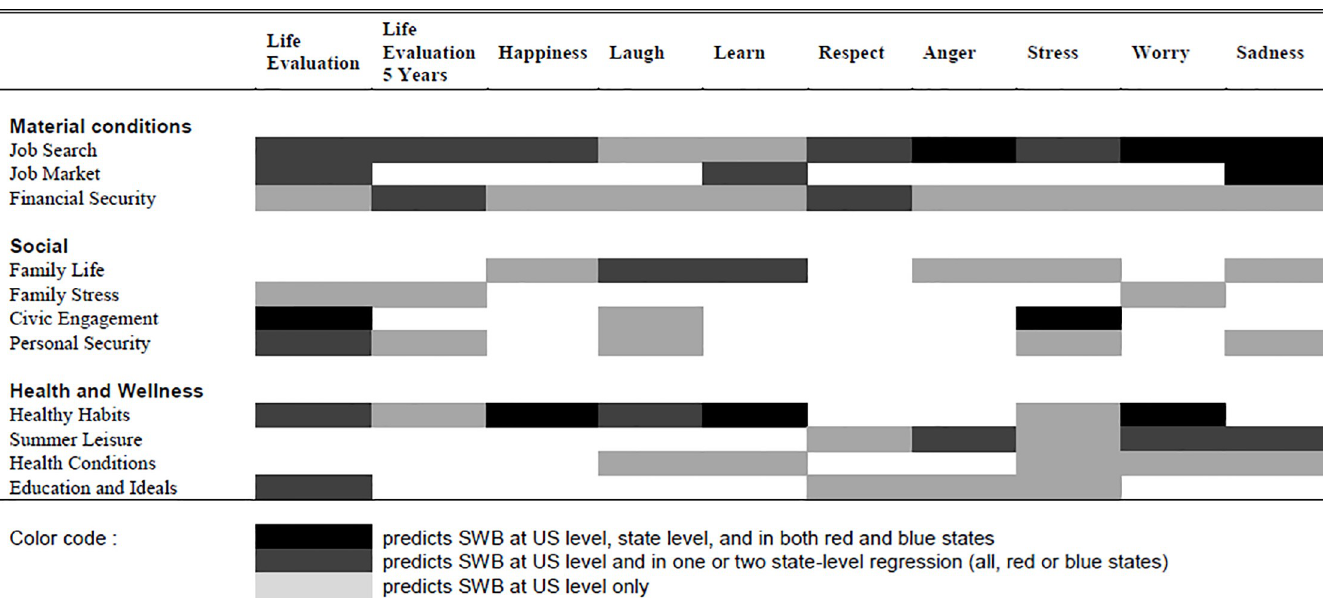
Fig 1. Mapping of significant predictors of subjective well-being across models. The figure shows the significance of different predictors across models. Job search, job market, civic engagement and healthy habits are all consistently important to predicting well-being across models.